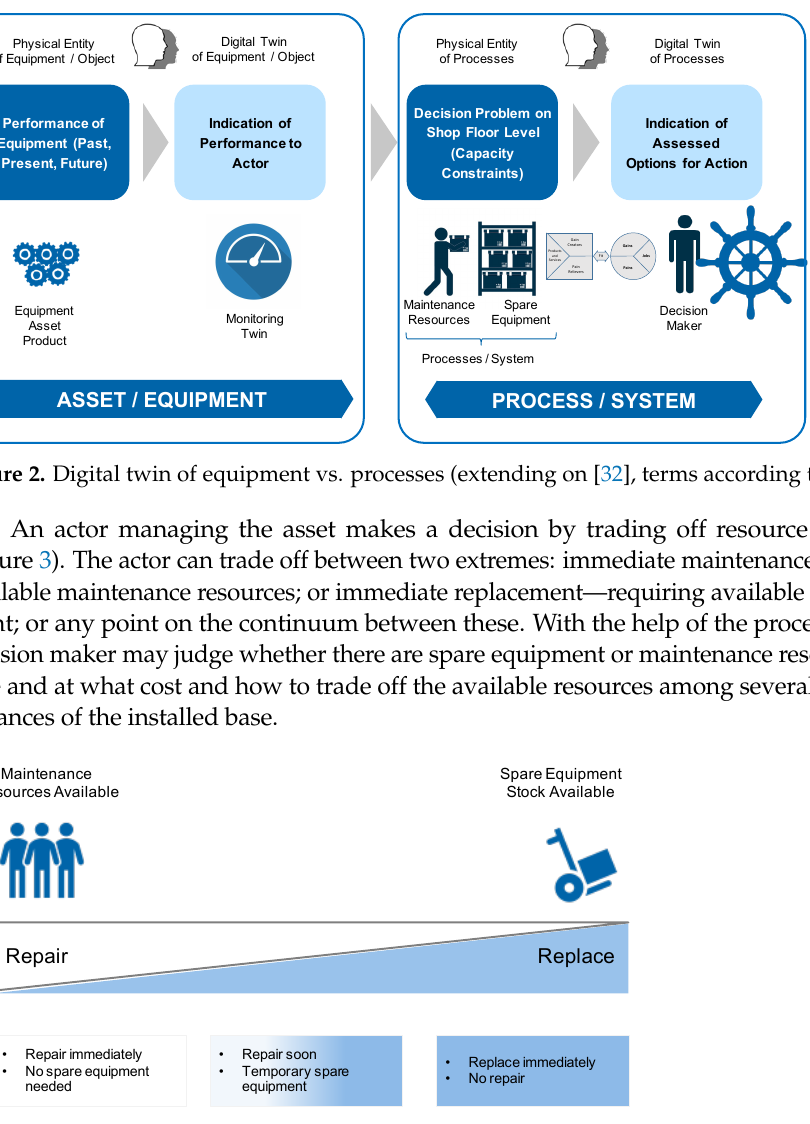
Figure 3. Tradingoff the decision between resources for maintenance and resources for spare equip- ment (adapted from on